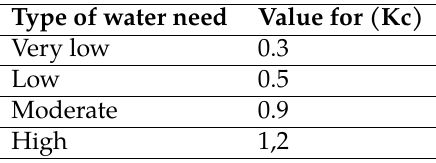
Table 3: Crop water